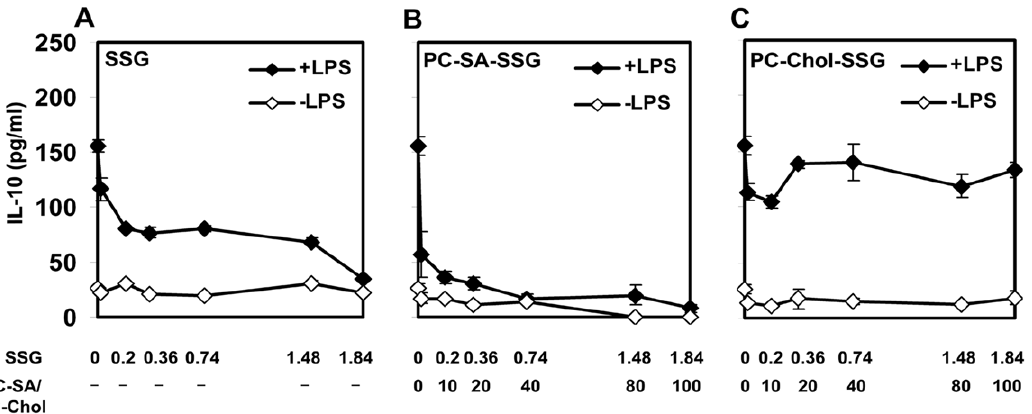
Figure 5. Immunomodulatory activity of free and vesicular SSG on splenocytes of normal BALB/c mice. Splenocytes of normal healthy mice were incubated with various concentrations of (A) free SSG, (B) PC-SA-SSG, and (C) PC-Chol-SSG with or without LPS (2.5 m g/ml) for 48 h at 37 u C with 5% CO 2 . IL-10 was measured from culture supernatants by enzyme-linked immunosorbent assay (ELISA). Each symbol represents mean cytokine level 6 SEM, representative of three independent experiments.